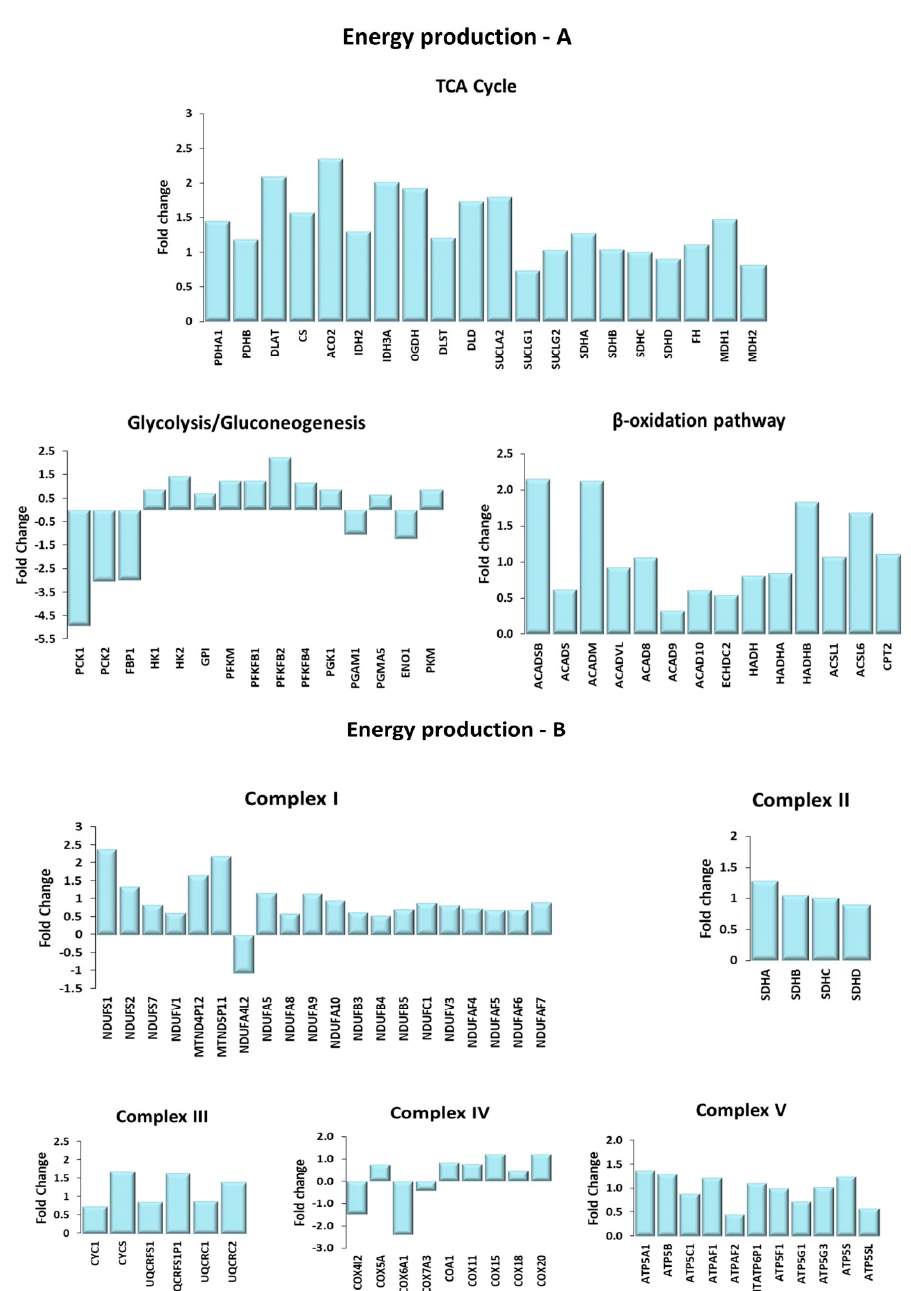
Figure 4. Energy production. Genes are shown here as fold change in the comparison of TRA and SED subjects. ( A ) TCA cycle. PDHA1, PDHB: pyruvate dehydrogenase E1 subunit α 1, β ; DLAT: Dihydrolipoamide S-acetyltransferase; CS: citrate synthase; ACO2: aconitase 2; IDH2: